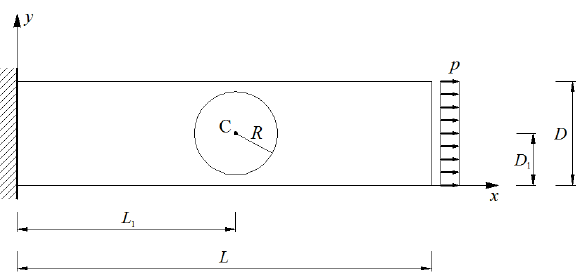
Figure 11: Geometry and loading condition of the cantilever elastic